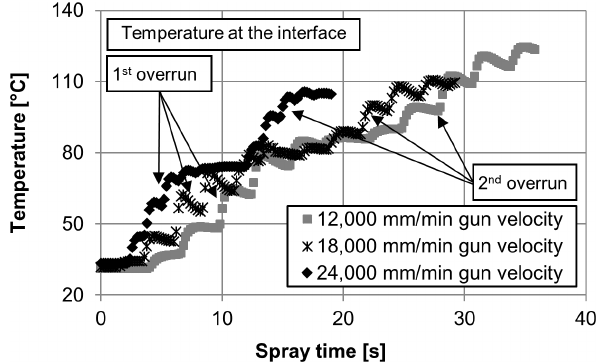
Figure 9. Evaluation of the temperature at the interface during spraying depending on the gun velocity. Since there is no flame enthalpy, the heat input is mainly induced by molten spray particles which splash onto the substrate. The spray particle temperature is higher than the steel liquidus temperature. The droplets in the spray plume cool down over the axial spraying distance interval from the realm of the molten pool to 110 mm (spray distance to the substrate). The two colour pyrometry system indicates that the spray particle temperature (for PGP = 0.6 MPa; current = 220 A,